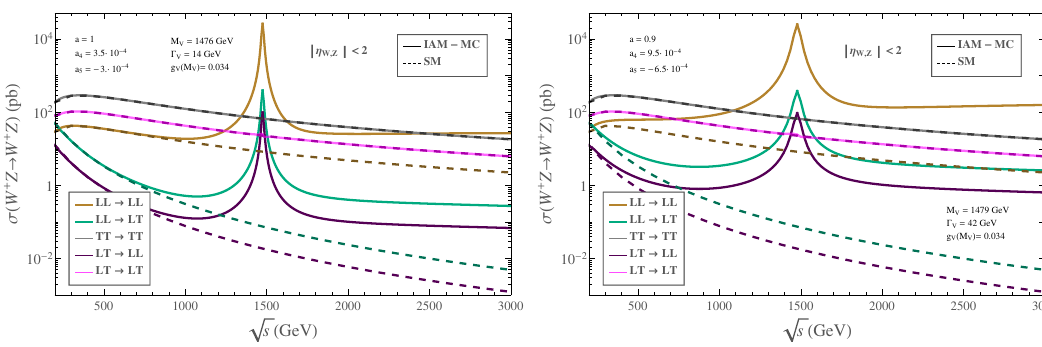
Figure 9 . Cross section (cid:27) ( W + Z W + Z ) as a function of the center of mass energy p s for the ! most relevant polarization channels and for the two selected benchmark points, BP1 (left panel) and BP1’ (right panel). Results were obtained imposing a cut on the center of mass scattering angle that corresponds to (cid:17) W;Z < 2. This cut will be used as a detector acceptance cut in the j j LHC process. Solid lines are the predictions from our IAM-MC model and dashed lines are the predictions from the